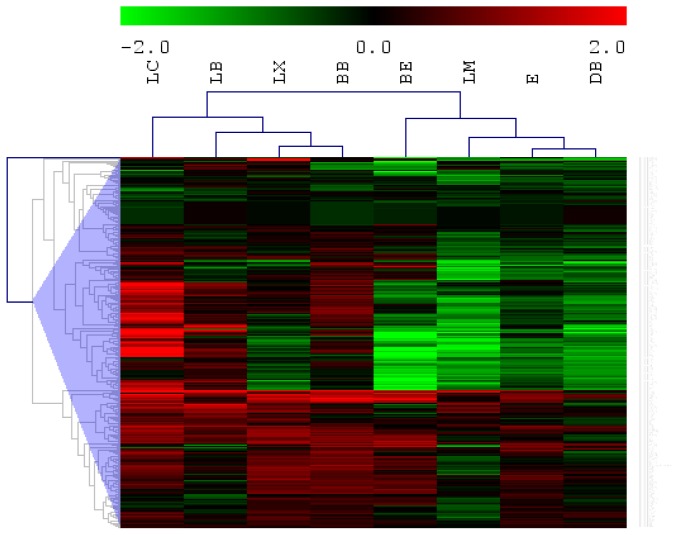
Hierarchical clustering of low/no risk ischemic stroke. Hierarchical clustering of blood miRNA profile of low/no-risk stroke patients (n = 8). Microarray data was normalized by average normalization using endogenous, small RNA controls on the microarray chip. For differential miRNA expression, the data was then normalized to the miRNA expression of the normal controls. The average intensities of each miRNA had been filtered by statistical testing (t-test, p < 0.05), normalized to the control readings and expressed as fold change and was selected for constructing the heat map. Green represents down-regulation while red represents up-regulation.